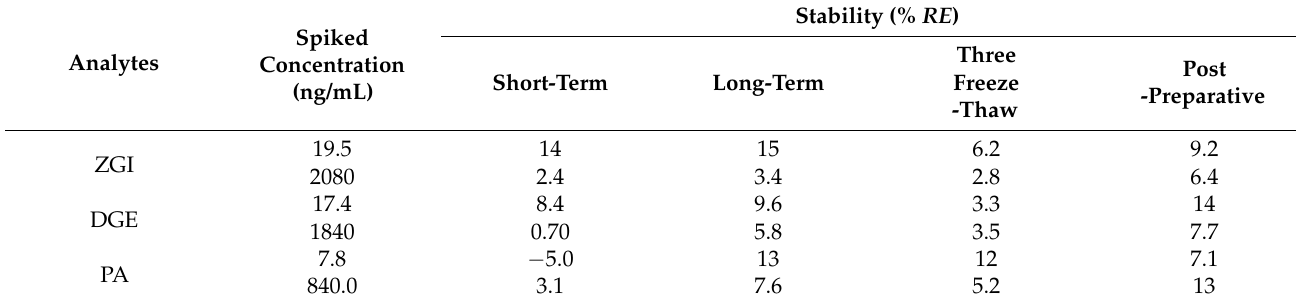
Table 4. Stability of the three analytes in rat plasma under various conditions ( n = 6).